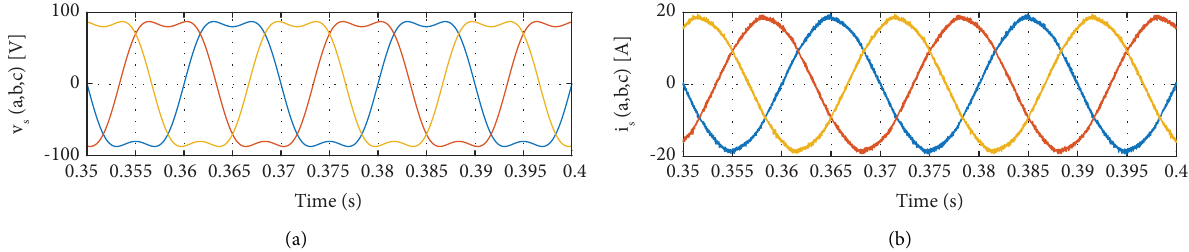
Figure 9: FIL cosimulation for APF using SC under unbalanced grid source voltage and current: (a) source voltages and (b) source currents.